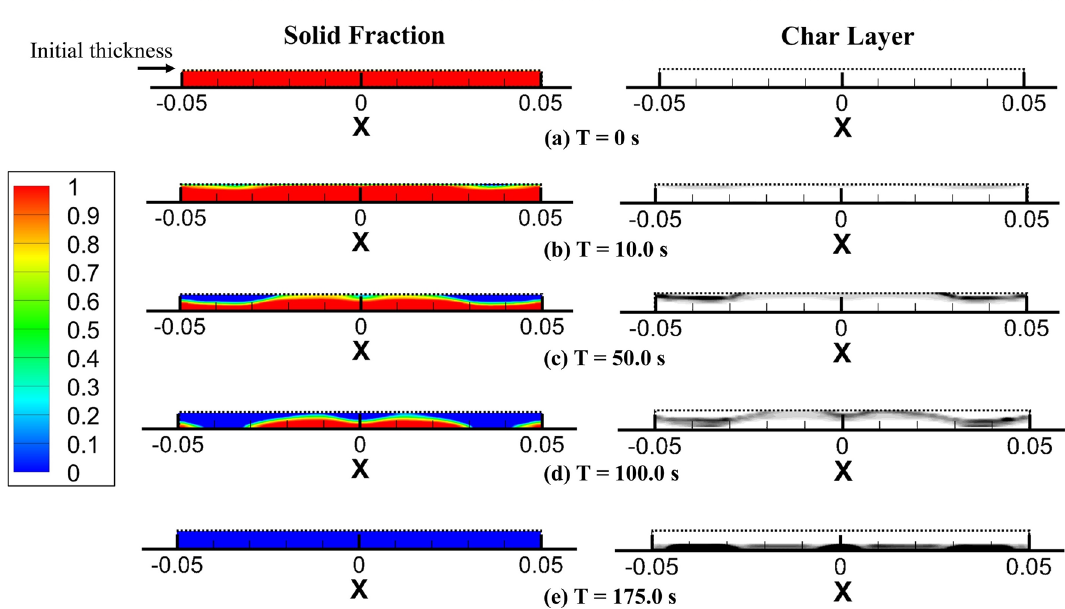
Figure 9. Three dimensional flame visualisation for 35 kW/m image for [CH/PA/Ti 3 C 2 ] 3 PUF at time instance: ( a ) T = 3.75 s, ( b ) T = 10.0 s, ( c ) T = 20.0 s, and ( d ) T = 100 s.